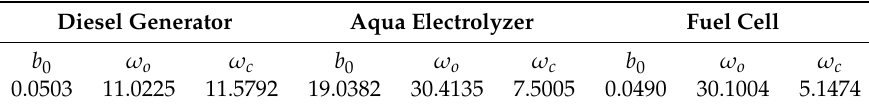
Table 5. The parameters of LADRC controller used for simulation.